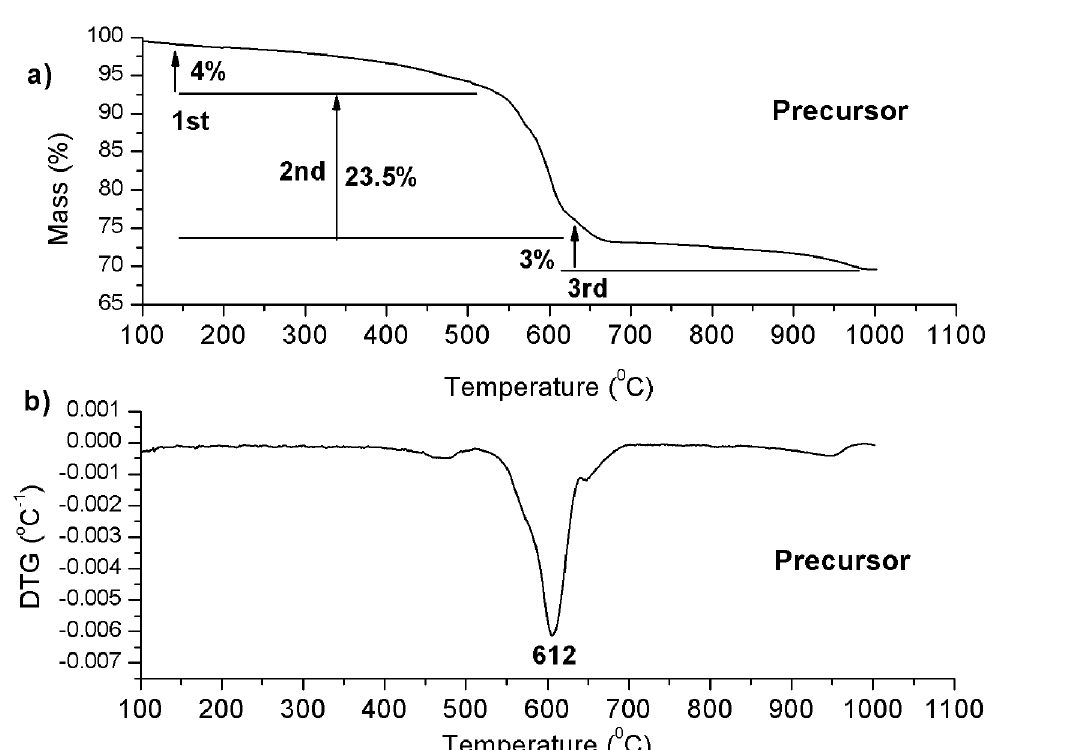
heat treated at different 3